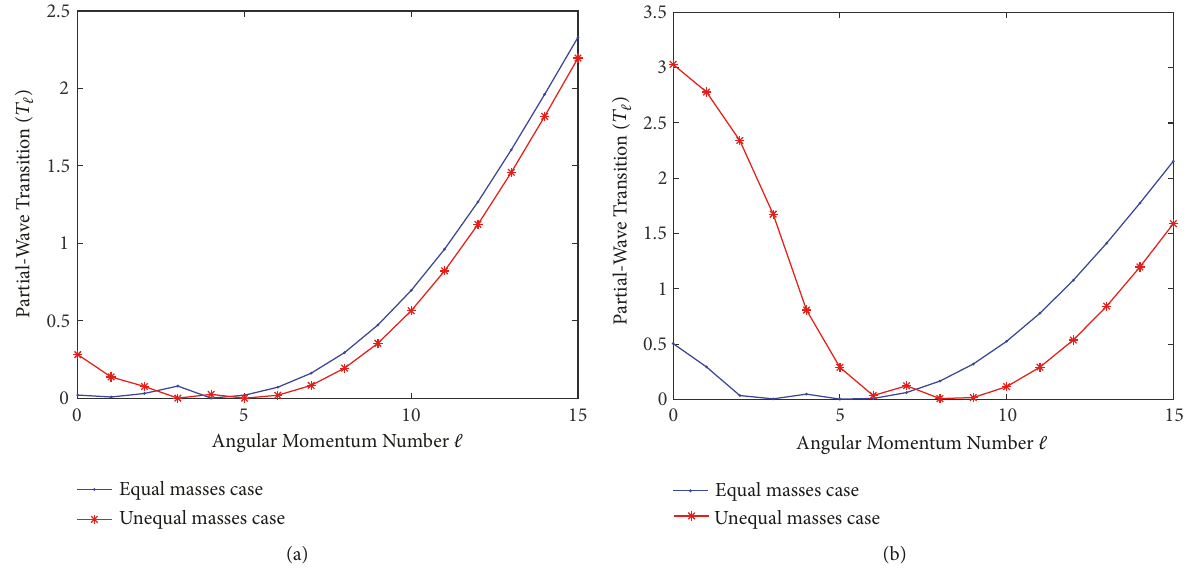
Figure 2: (a) Partial-wave transition for the spinless Salpeter equation with the Hellmann potential as a function of angular momentum quantum number 𝑙 with 𝑎 = 0.2,𝑏 = −1 , 𝐸 𝑛,𝑙 = 1, 𝜌 = 0.5 . (b) Partial-wave transition for the spinless Salpeter equation with the Hellmann potential as a function of angular momentum quantum number 𝑙 with 𝑎 = 2,𝑏 = −1 , 𝐸 𝑛,𝑙 = 1, 𝜌 = 0.5 .